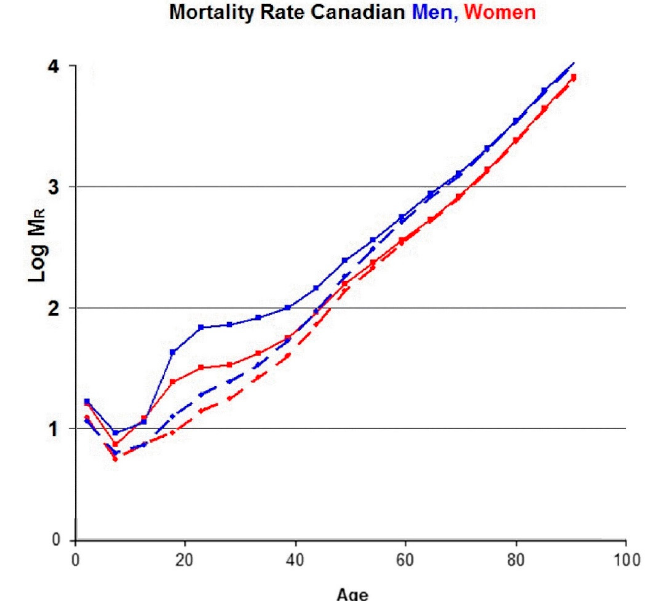
Figure 4. The solid lines are the logarithm of the age-dependent total mortality rates per 10 5 population for Canadian men (blue) and women (red) in 2013. The dashed lines are the same data after subtracting the mortality due to accidents, suicides, and assaults.